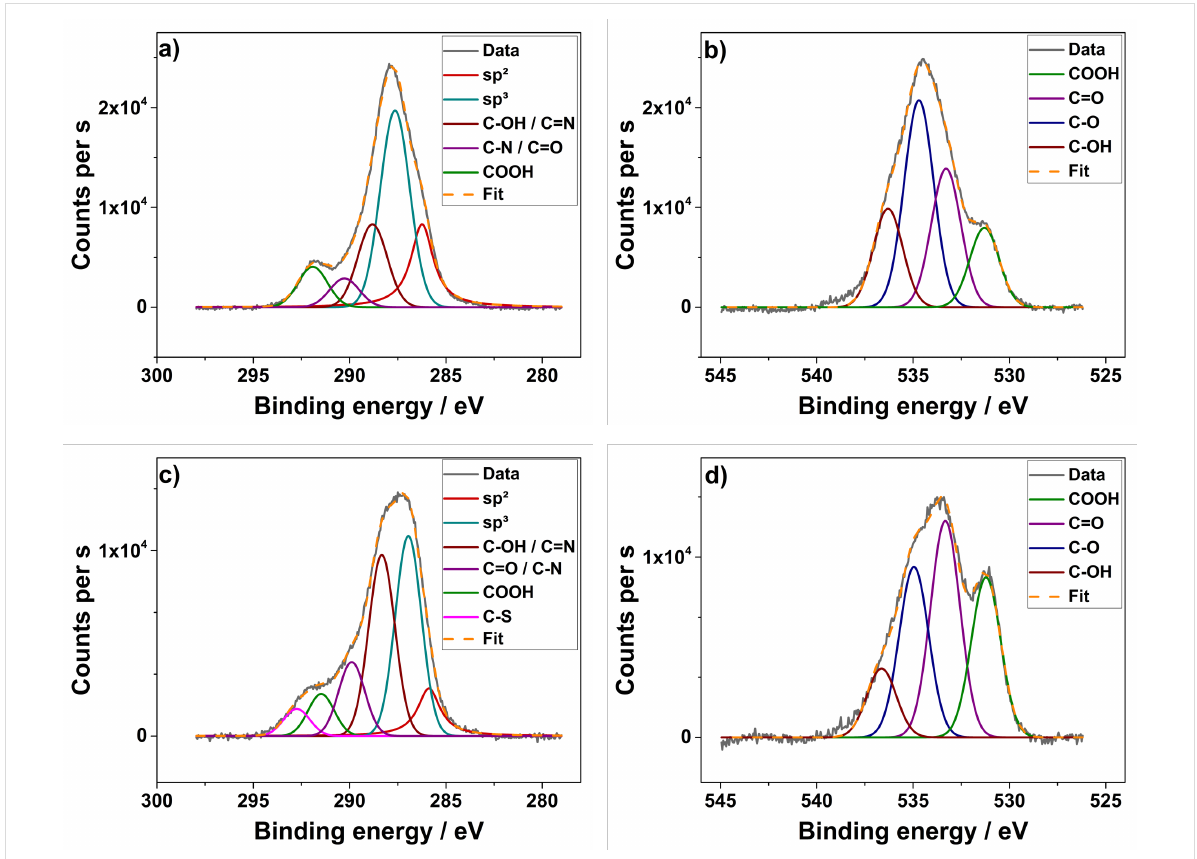
Figure 5: High-resolution XPS spectra including the fitting of the carbonized carbon felt (a,b) and the co-doped composite electrode (1000 / N+S; c,d): spectra of C 1s (left) and O 1s region (right).